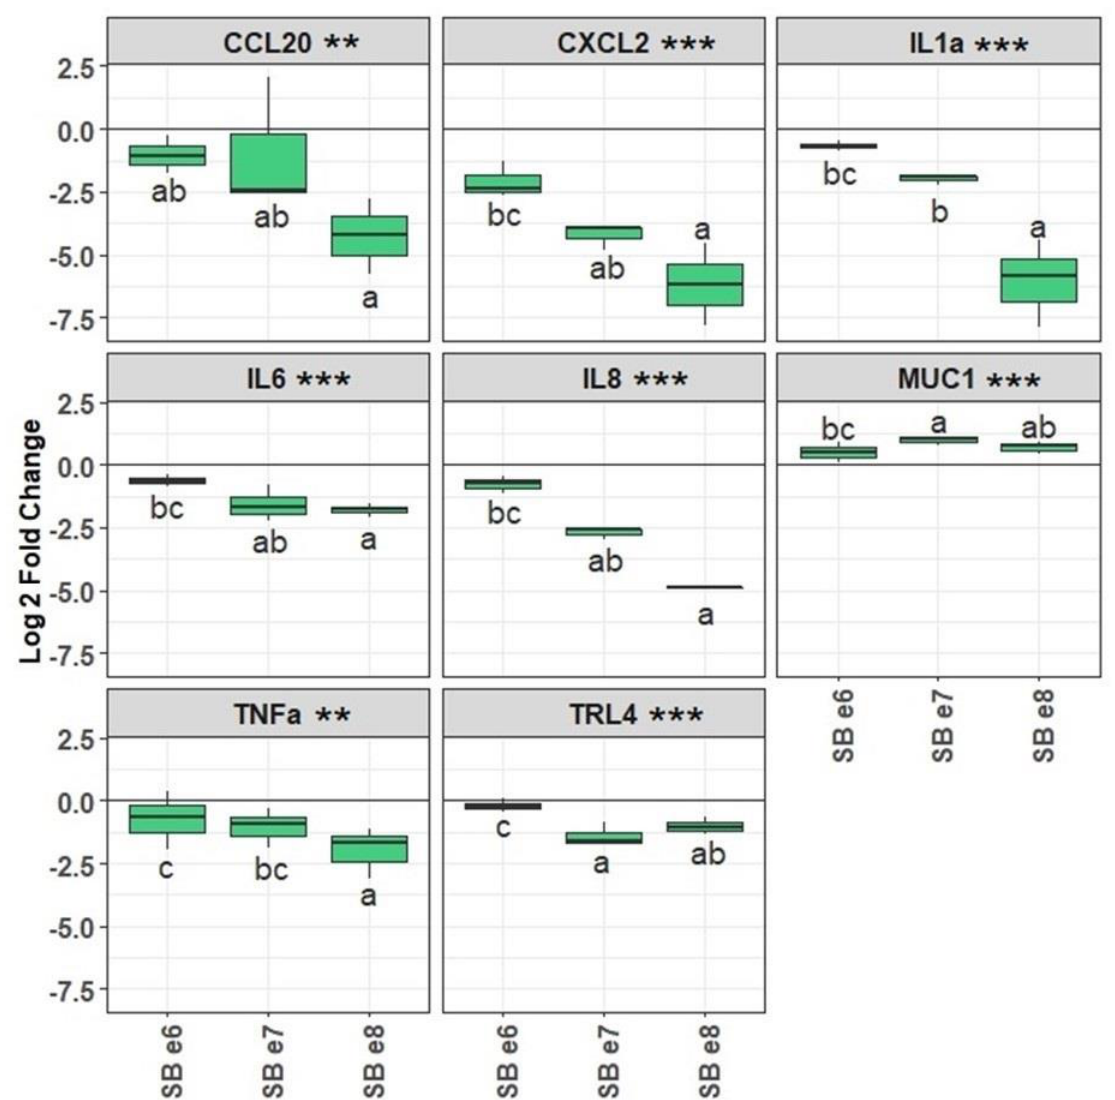
Figure 2. Gene expression of IPEC-J2 cells challenged with the ETEC Ec105 strain and treated or not with different doses of SB CNCM I-1079. Log 2 fold changes represent the differential gene expression between non-SB treated and SB treated ETEC-challenged IPEC-J2 cells (n = 3). Conditions with the same letters are not statistically different from each other, while different letters indicate that the conditions are statistically different from each other. The denominations e6, e7, and e8, respectively, correspond to the doses of 10 6 , 10 7 , and 10 8 CFU/well of SB incubated with the ETEC-challenged IPEC-J2 cells ( p value codes: *** < 0.000; ** < 0.001).